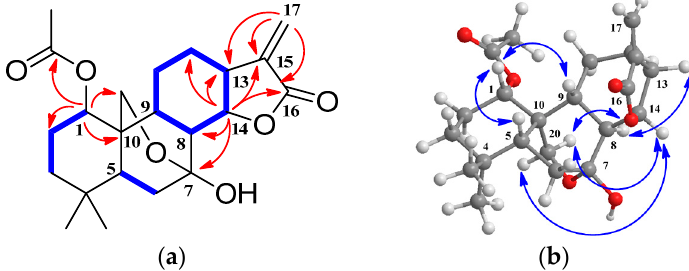
Figure 2. The 2D NMR correlations of compound 1 : ( a ) 1 H- 1 H correlation spectroscopy ( 1 H- 1 H COSY) (bold) and selected heteronuclear multiple bond correlations (HMBC) (arrows); ( b ) The rotating-frame overhauser effect spectroscopy (ROESY) correlations. Table 1. 1 H-NMR spectroscopic data for compounds 1 – 4 in pyridine- d 5 ( δ in ppm, J in Hz).